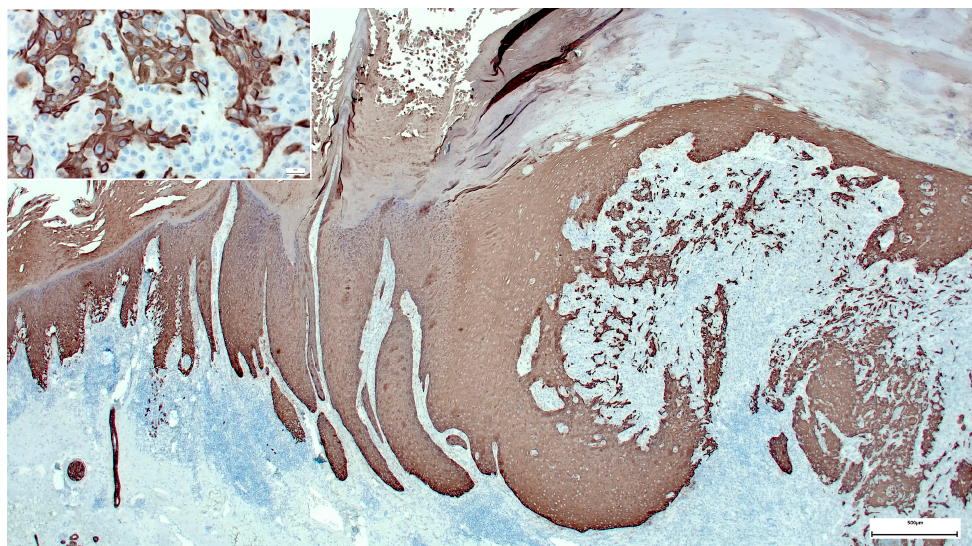
Figure 4. High molecular weight cytokeratin (clone 34 β E12) stain highlighting the epithelial component of the collision tumor.